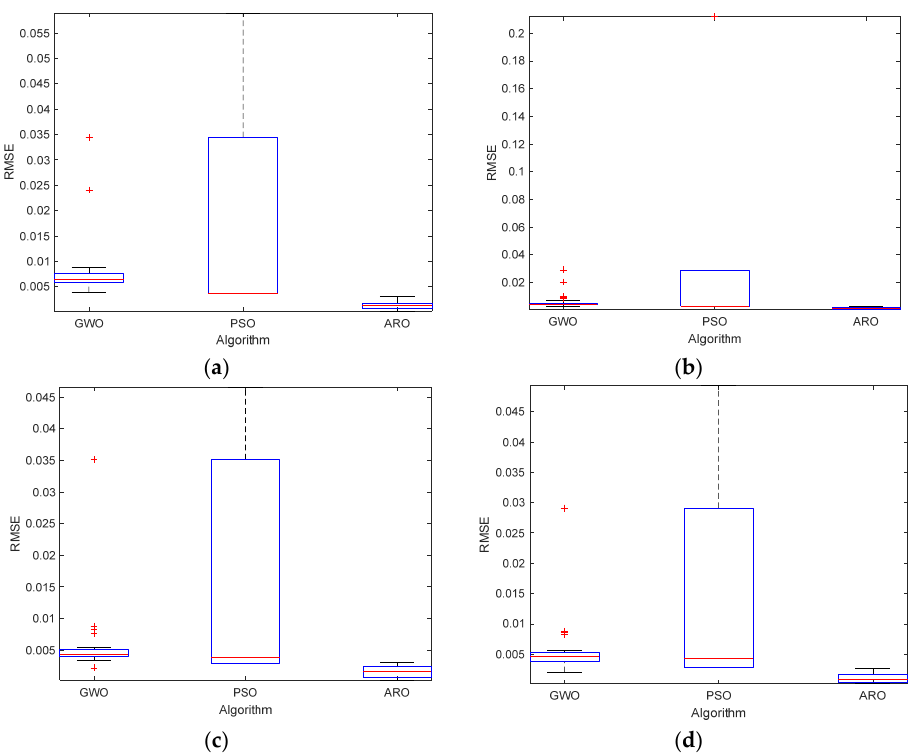
Figure 14. Boxplot of different algorithms at various environmental conditions: ( a )1 atm, 1173 K; ( b ) 1 atm, 1273 K; ( c ) 3 atm, 1173 K; and ( d ) 3 atm, 1273 K.